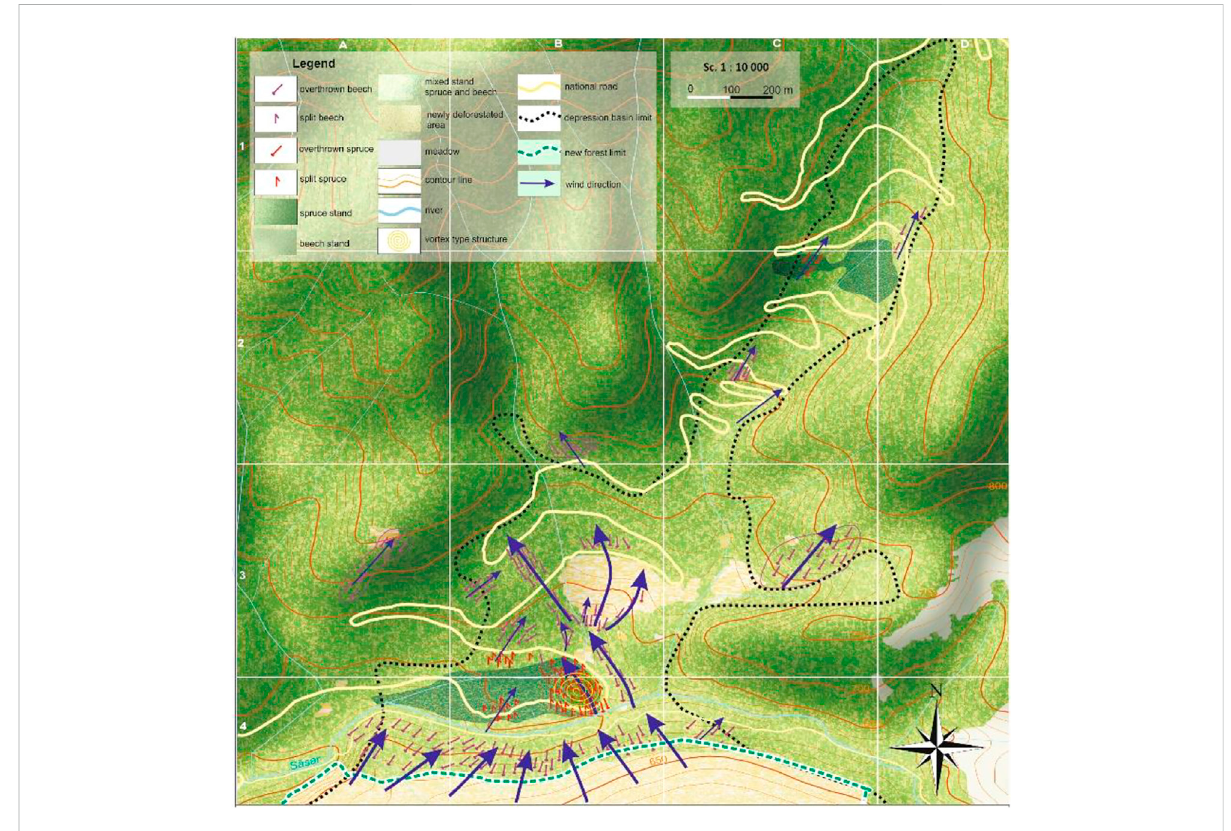
FIGURE 12 Gutai West area. Map of the wind directions presented to the